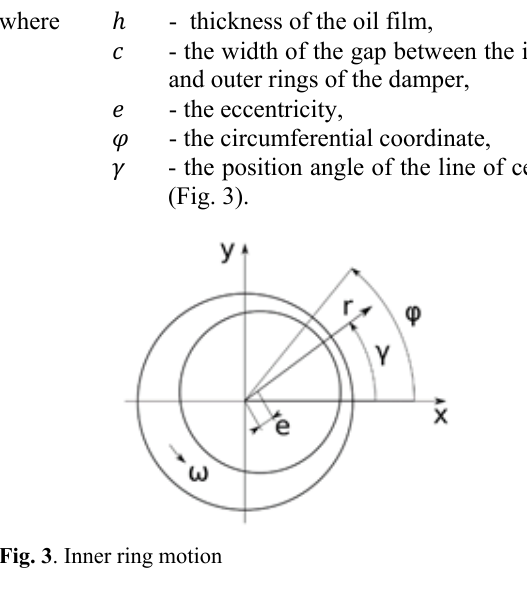
Fig. 3 . Inner ring motion